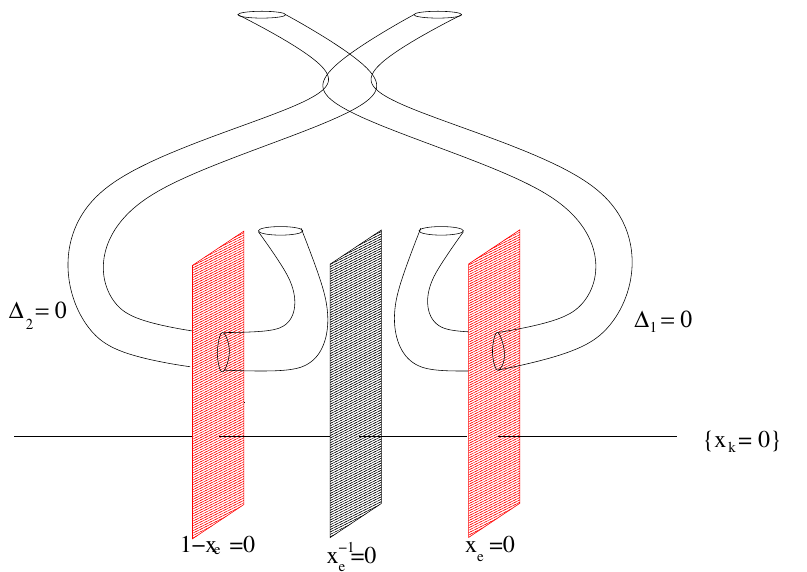
= 0 and x = 1 . These e e = 0 } , which k